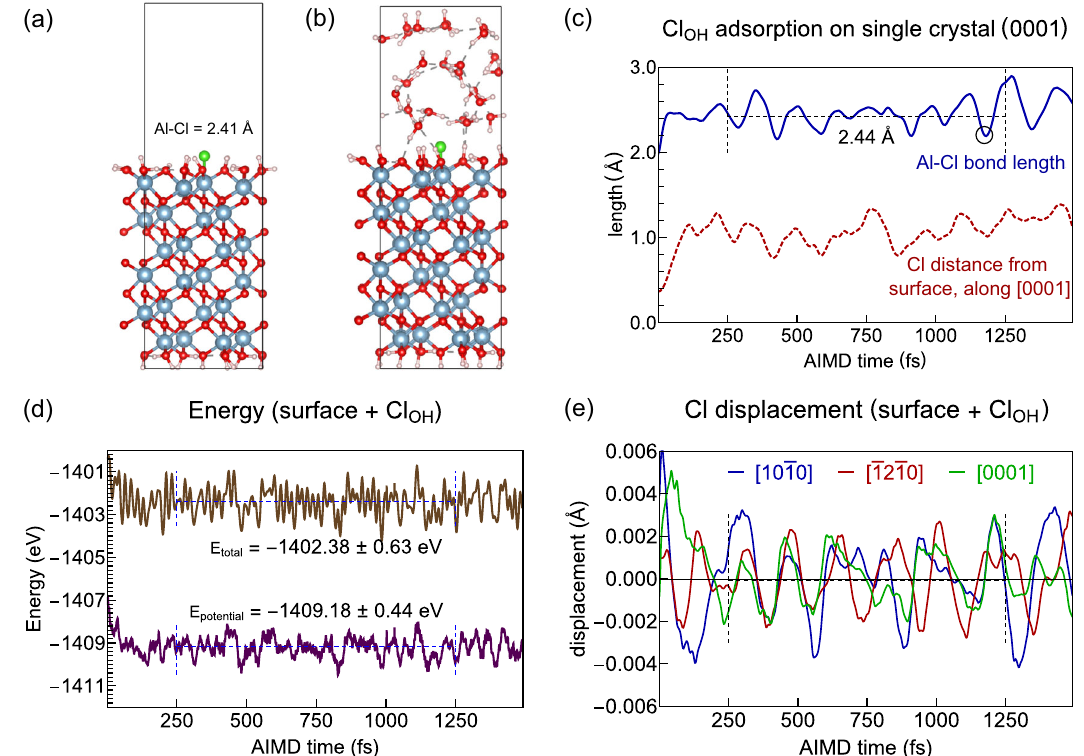
Fig. 5 Adsorption of substitutional Cl OH on single-crystal (0001) surface. a Con fi guration after zero-K DFT minimization, b Con fi guration after 1175 fs AIMD at 300 K, c Al – Cl bond length (solid blue) and Cl distance from the surface along [0001] (dashed red) during the AIMD simulation in b. d Variation of total (E total ) and potential (E potential ) energy of the system and e the displacement of the Cl atom at each time step along the three orthogonal axes of the simulation